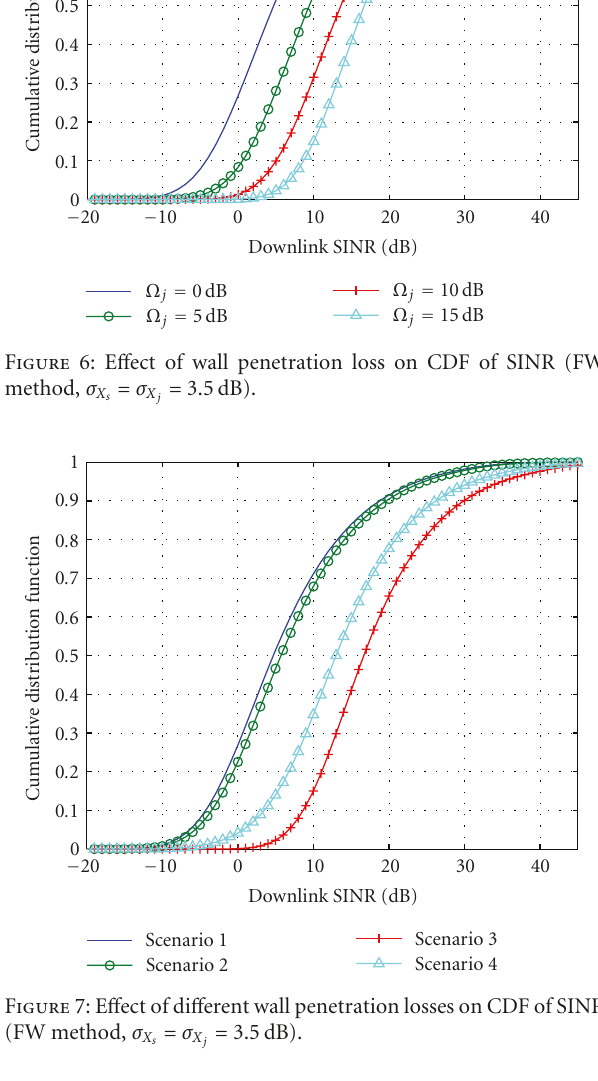
Figure 5: Kullback-Leibler Distance between simulation and = σ = 3.5 dB). analysis ( σ X X j s